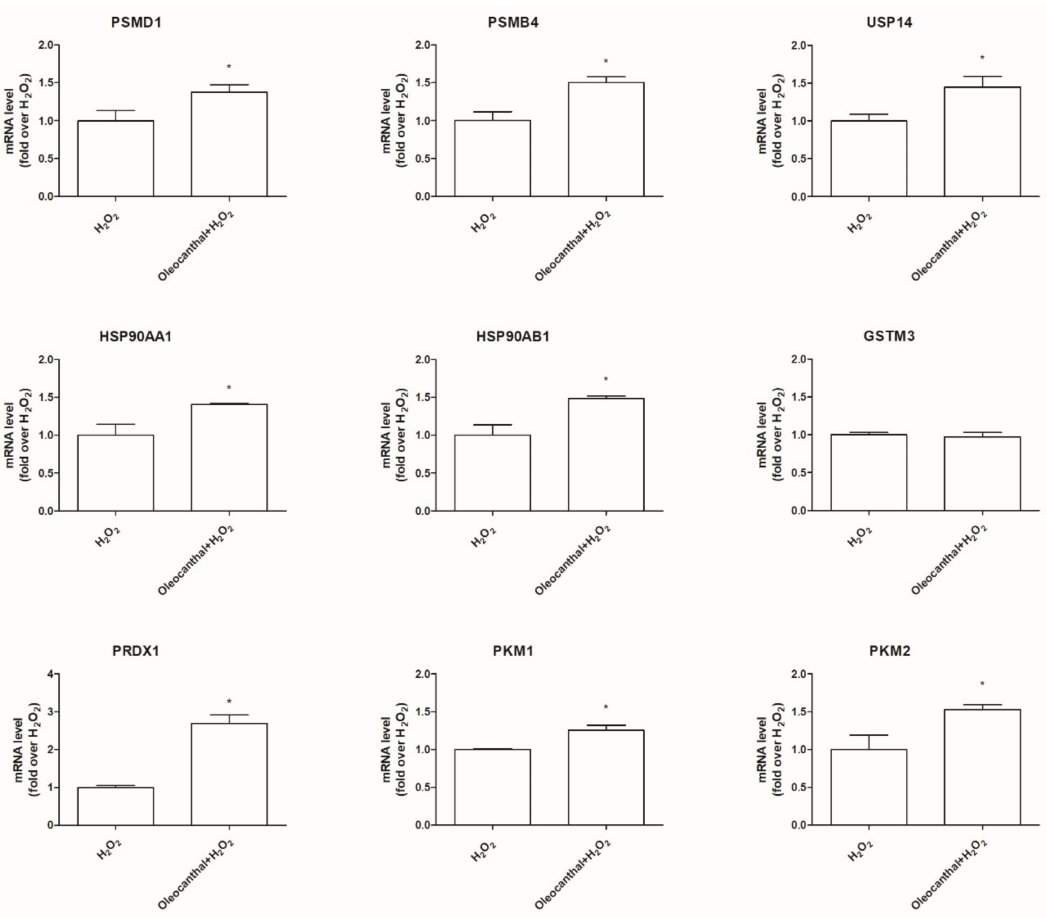
Figure 7. Transcriptional validation of proteomic data. Differentiated SH-SY5Y were pretreated with 10 µ M oleocanthal for 24 h and then exposed to 700 µ M H 2 O 2 for 1 h. Total RNA was isolated, and the mRNA level of target genes was quantified using RT-PCR normalized to 18S rRNA reference gene as reported in Materials and Methods. Triplicate reactions were performed for each experiment. Each bar represents the mean ± SEM of three independent experiments. Data were analyzed by Student’s t- test. * p < 0.05 with respect to H 2 O 2 .